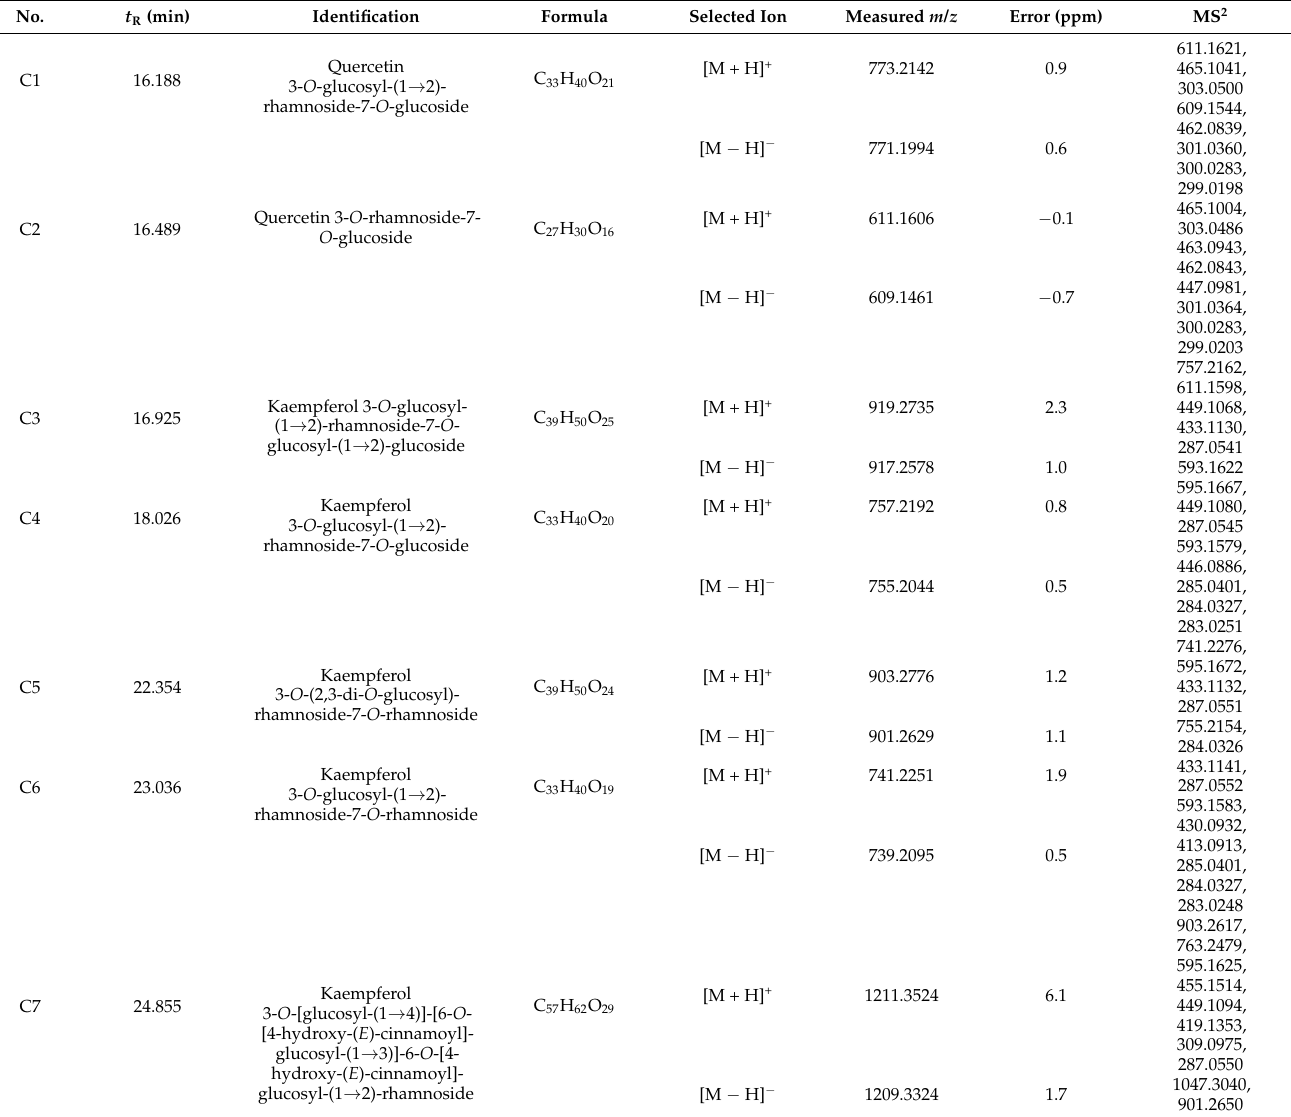
Table 2. Identification of the main phytochemicals in S. ternatum using